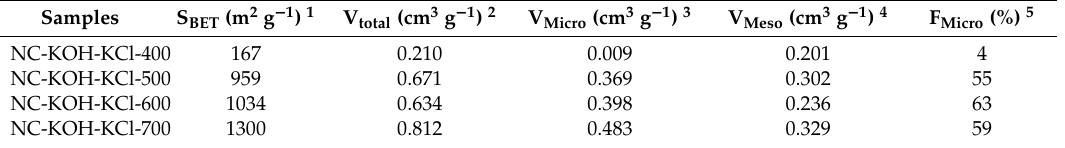
Table 4. BET surface area and porosity of samples carbonized at di ff erent temperatures.